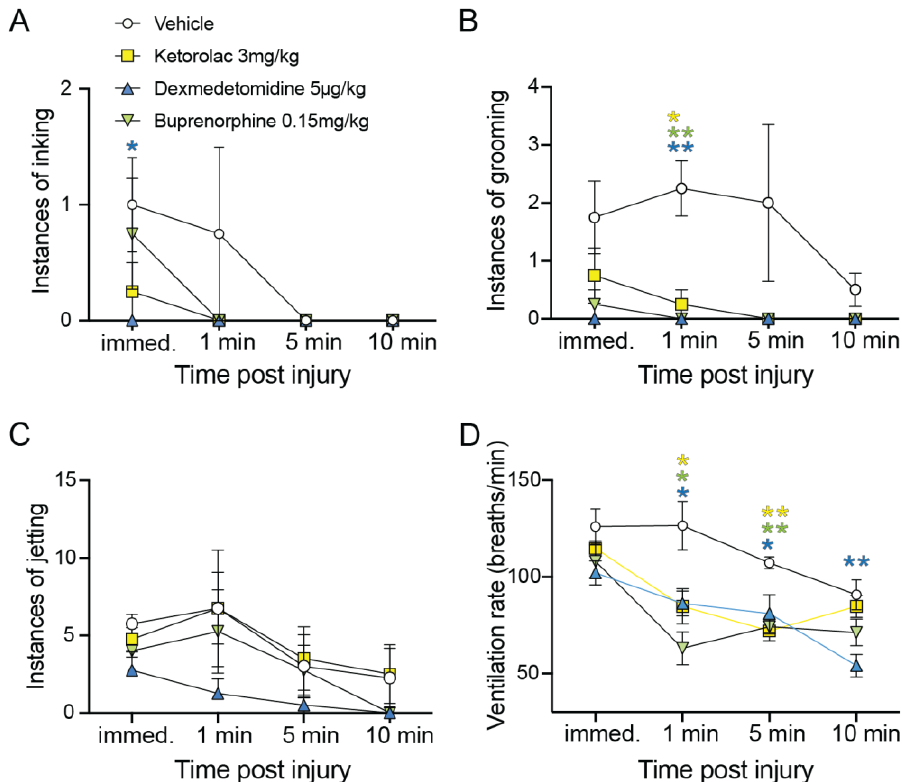
Figure 4. Pain-like behavior is suppressed by systemic analgesics. ( A ) Number of individual ink plumes released in response to fin pinch, and at one, five and ten minute intervals thereafter. Only dexmedetomidine significantly reduced inking ( p = 0.04, unpaired t -test), although overall the instances of inking were low and these data show likely floor effects. ( B ) Site-directed grooming with the arms occurred repeatedly in control squid, but was significantly suppressed by all three drugs at one minute post-injury (Ket, p = 0.01, Dex, p = 0.003, Bup, p = 0.003, Bonferroni-corrected, unpaired t -tests). ( C ) Jetting showed no significant effects at any time point. ( D ) Ventilation rate, which is used as an indicator of pain in fish, was significantly higher in control squid at one and five minutes post-pinch compared with all three drug-treated groups (control vs. ketorolac, p = 0.03. Control vs. dexmedetomidine, p = 0.02, control vs. buprenorphine, p = 0.005, ( D )). The suppression of respiratory rate was still present at five minutes for all drugs (control vs. ketorolac, p = 0.001. Control vs. dexmedetomidine, p = 0.04, control vs. buprenorphine, 0.004), but only for dexmedetomidine at 10 min post-pinch (vs. control, p = 0.008, ( D )). Points show mean and error bars are standard error of the mean (SEM). * p , 0.05. ** p , 0.01. Colors of asterisks show comparisons of each color